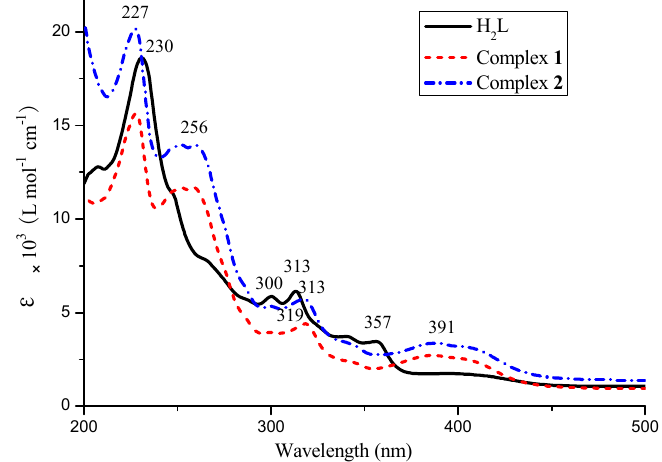
Figure 2. UV-Vis absorption spectra of H 2 L and the Co(II) complexes 1 and 2 in dilute DMF solution at room temperature (c = 5 × 10 − 5 mol/L).